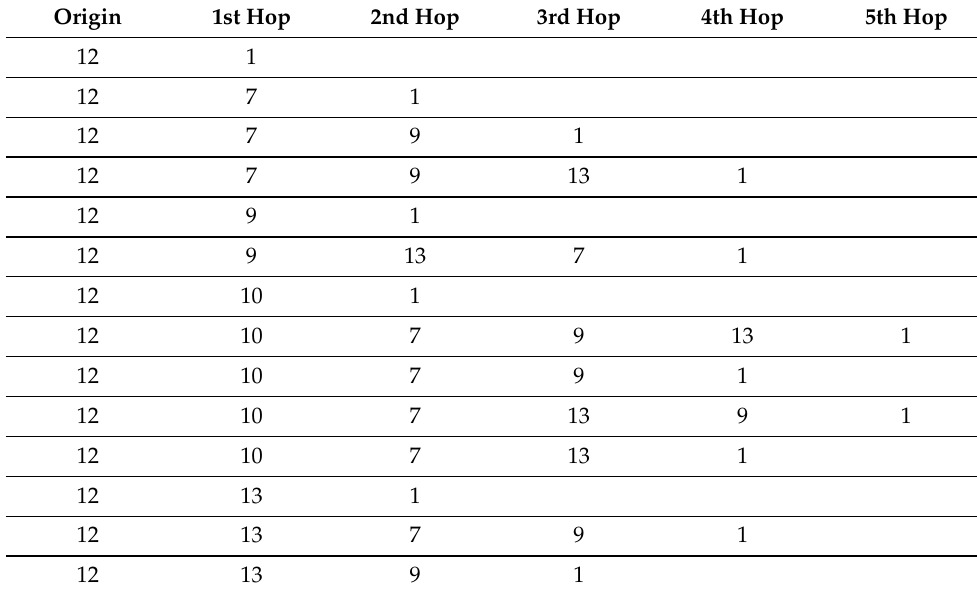
Table 1. CTP Routes of node 12 origin.